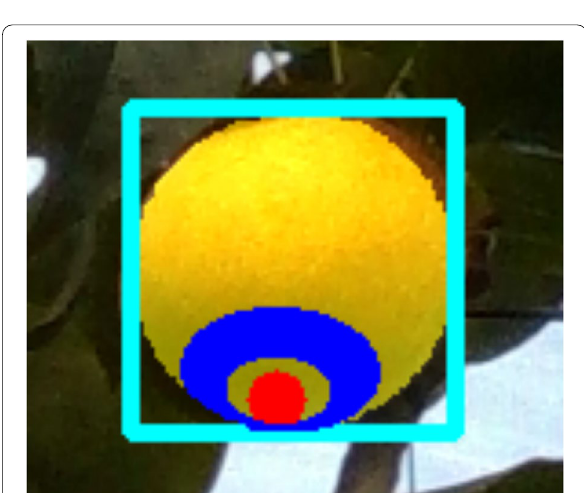
Fig. 9 Detected area for determining